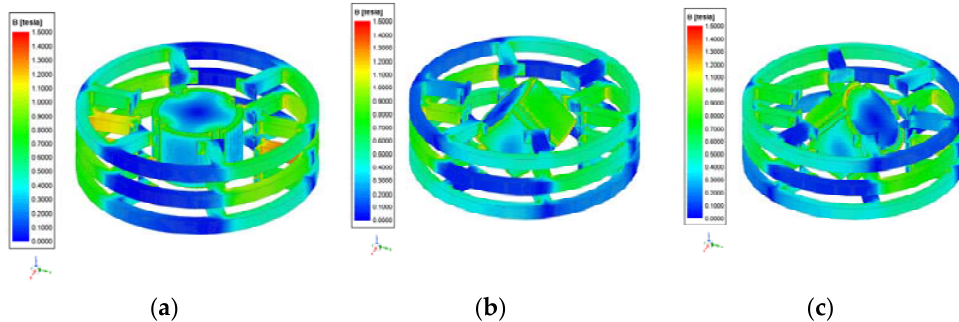
Figure 8. Magnetic field distributions of the motor at loaded conditions rotating around the X ‐ axis: ( a ) view of the motor that is at α = 0°; ( b ) view of the motor that is at α = +45°; ( c ) view of the motor that is at α = − 45°.